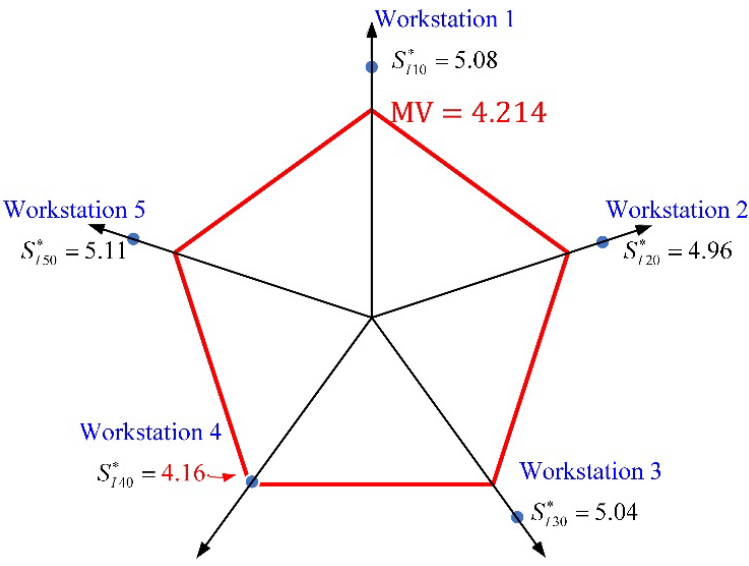
Figure 3. Radar evaluation chart of service operation performance for multiple workstations .